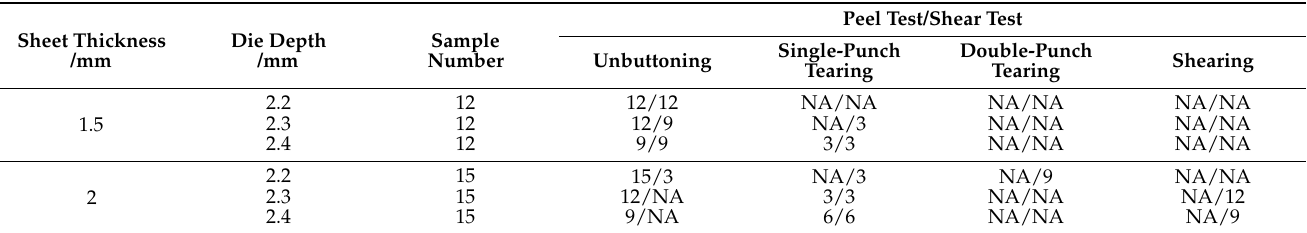
Table 3. Number of joint failures by failure type in shear and peel tests.